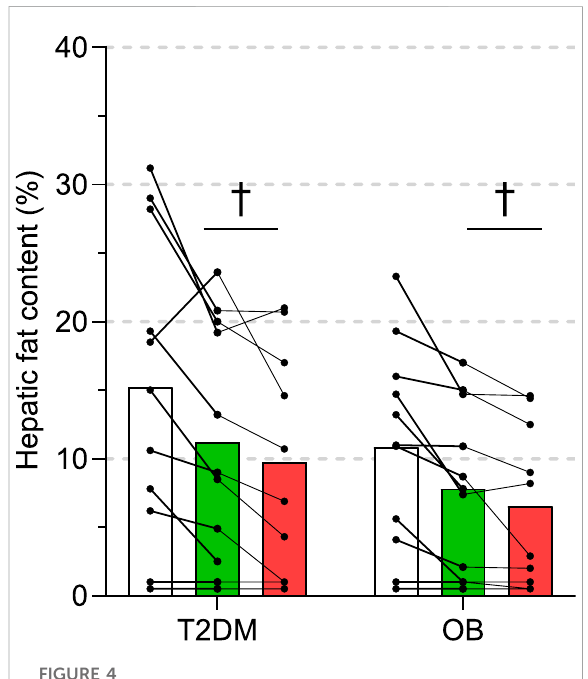
FIGURE 4 Intrahepatic triglyceride content measured by 1 H-magnetic resonance spectroscopy in eleven subjects with obesity (OB) and eleven patients with type 2 diabetes (T2DM). Experiments were performed at baseline, after 3 weeks of alternate-day fasting with double diet on non-fasting days (ADF), and after 3 weeks of alternate-day fasting with ad libitum diet, i.e. weight loss was allowed (ADF + WL). Data are shown as mean ± SD. † denotes different from baseline ( p <